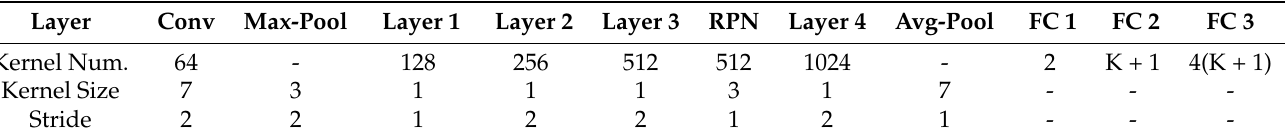
Table 2. Architecture of the discriminator in CMTGAN. K denotes the number of object categories. Layer